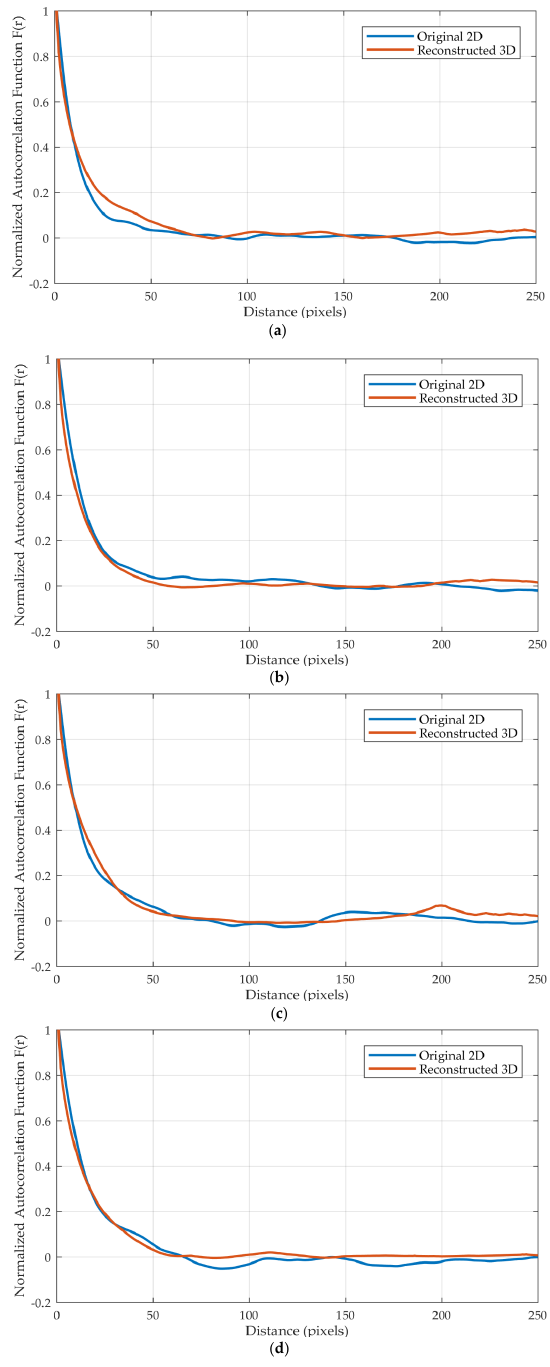
Figure 9. Comparison of autocorrelation functions of SEM images and 3D reconstruction models with thermal shock cycles are ( a ) 50; ( b ) 100; ( c ) 150; ( d ) 250.